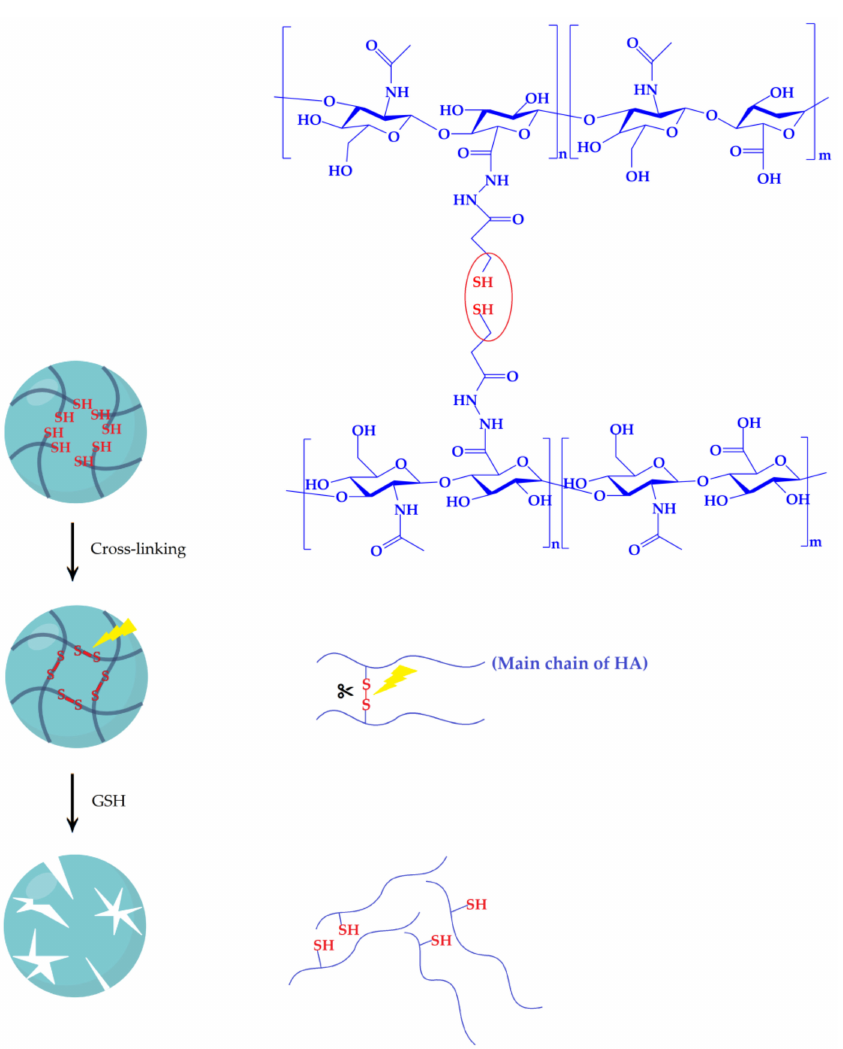
Figure 5. Illustration of cross-linking and redox response degradation behavior of the